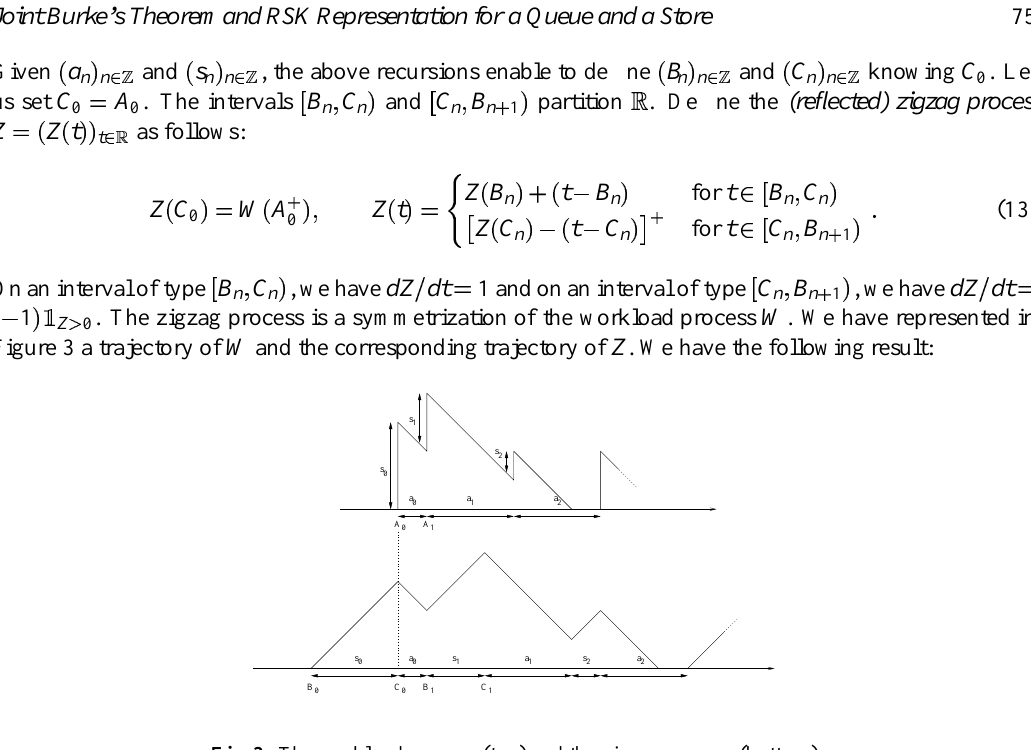
Fig. 3: The workload process (top) and the zigzag process